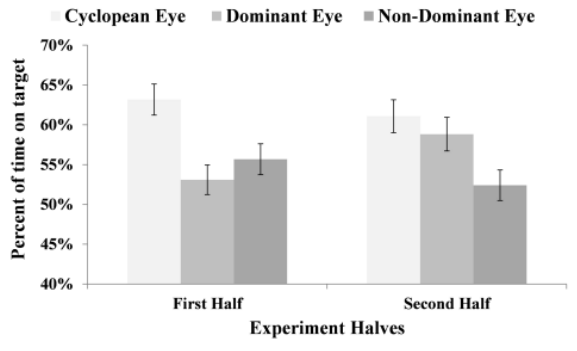
Figure 6: Tracking-performance with cyclopean, dominant, and non-dominant eye-control in the first and second halves of the experiment. Error bars represent standard